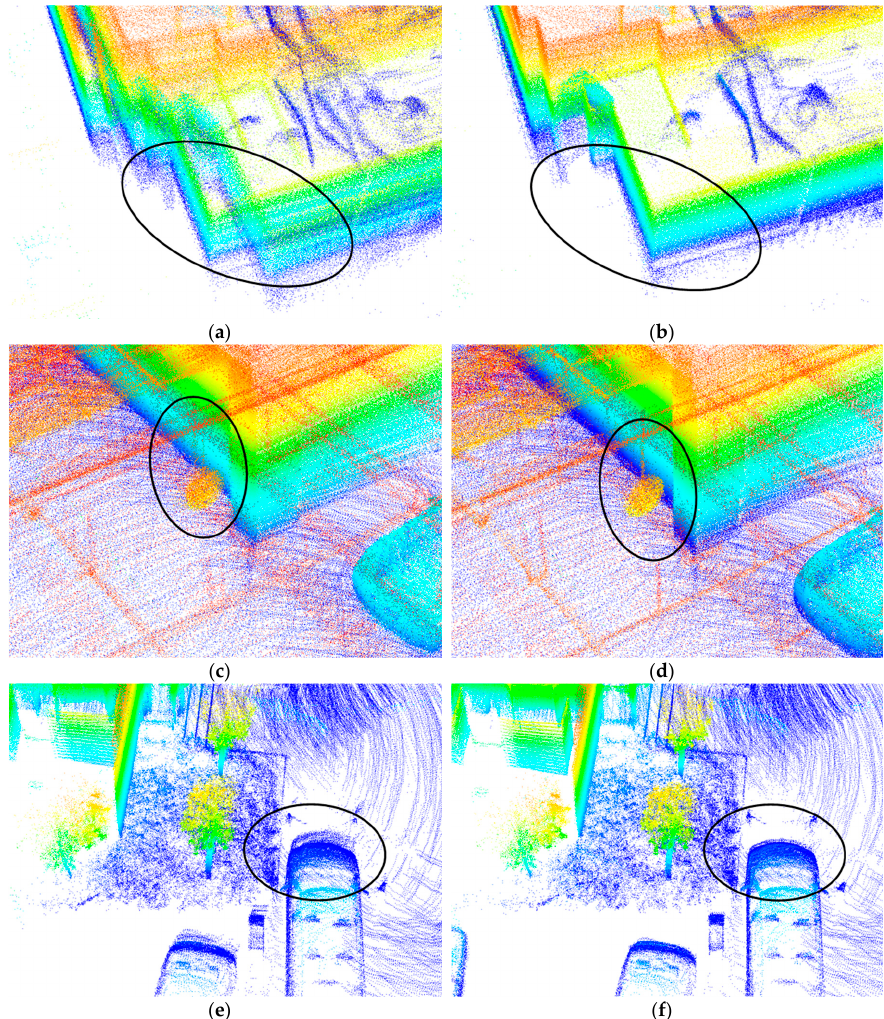
Figure 13. Snapshots of the point cloud produced by LOAM before (left) and after optimization (right). ( a , b ) A scene in dataset 1; ( c , d ) a scene in dataset 2; ( e , f ) a scene in dataset 3.